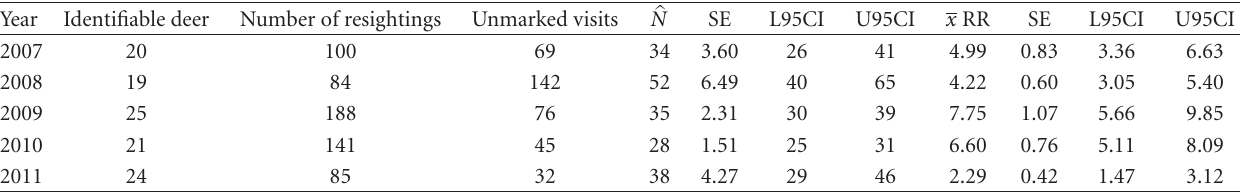
Table 3: Number of identifiable deer, resightings, visits by unmarked individuals, abundance estimates ( (cid:2) N ), and mean resighting rates ( x RR) along with standard errors (SE) and 95 percent confidence intervals (L95CI and U95CI for lower and upper 95% confidence intervals) for female mule deer in western Utah, USA, 2007–2011 estimated using program MARK. Identifiable deer Number of resightings (cid:2)